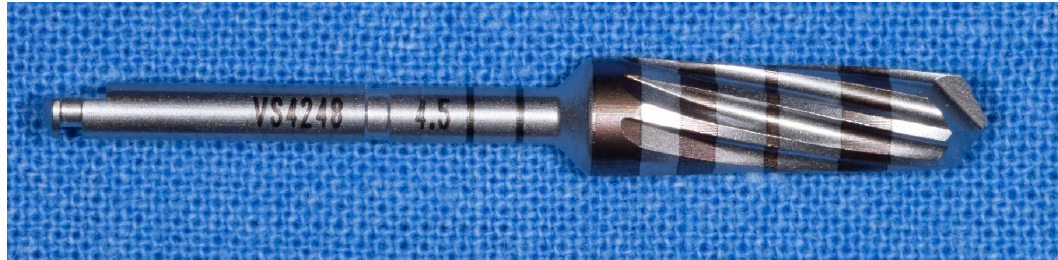
Figure 9. Fifth cutter with a diameter of 3.0 mm in the method “implant drilling with bone compaction instrumentation technique.”